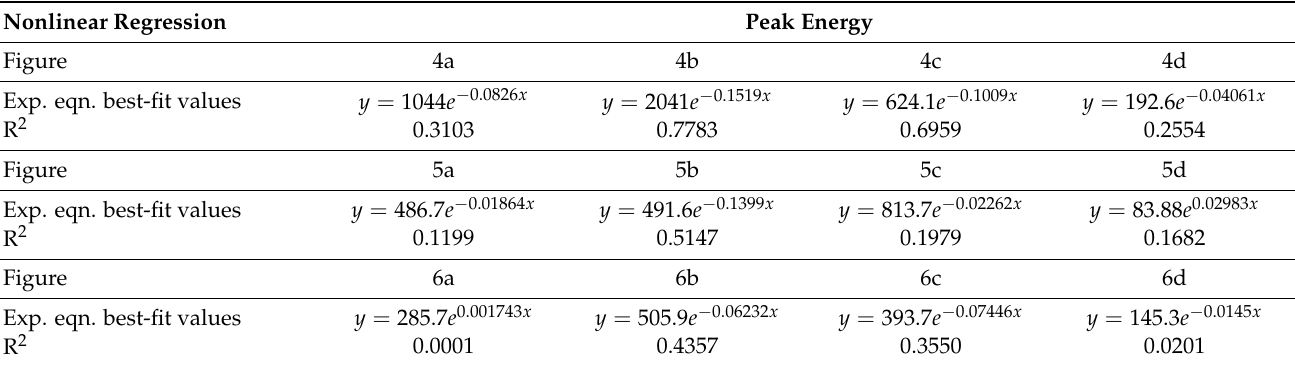
Table 2. Curve-fitting of Figures 4–6. The degree of convergence of the pitch consistency analogous to the goodness of fit (R 2 ) may suggest fixation quality.